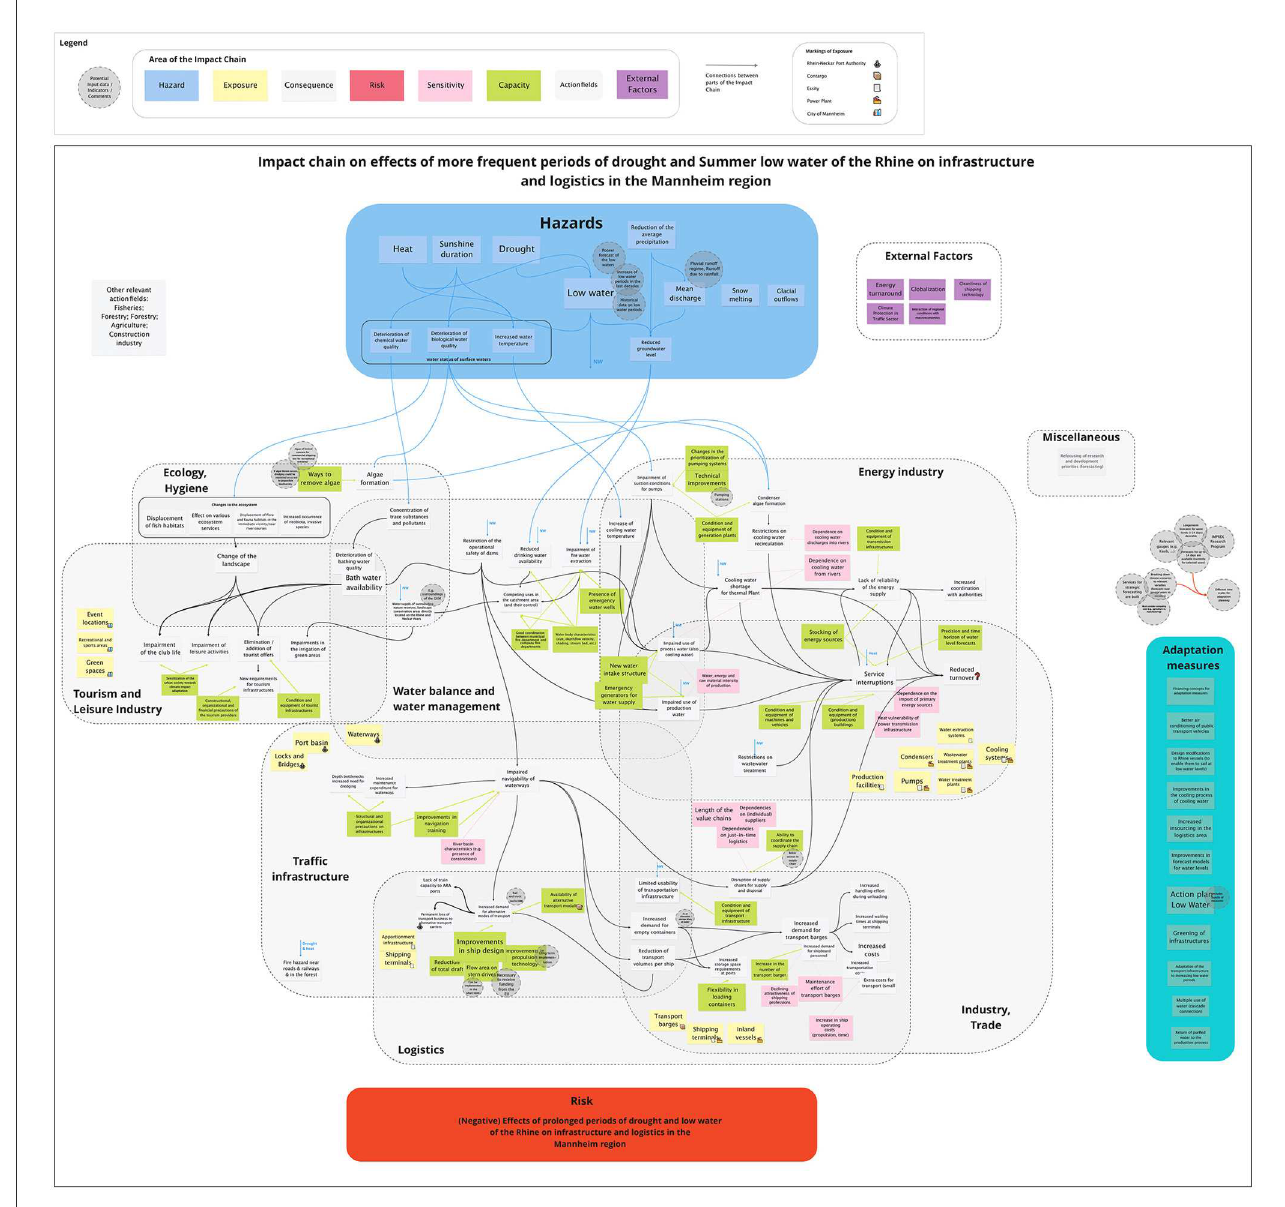
FIGURE6 Impact Chain depicting the results of the qualitative assessment of the risk of “negative impacts of extended periods of drought and low waters of the Rhine River on infrastructure, logistics and population in the metropolitan region of